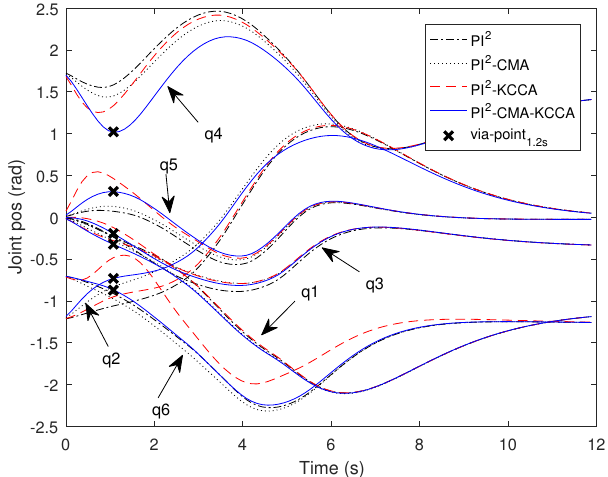
Figure 7. One via-point task when the number of iterations is